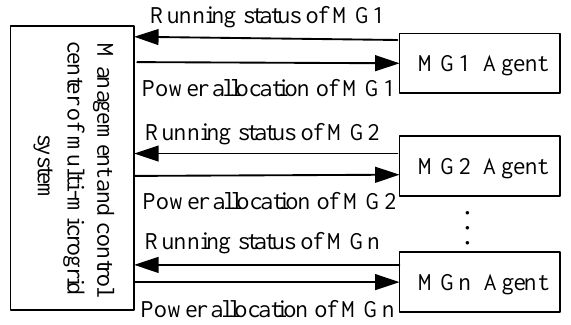
Figure 2. Management framework of upper microgrids.